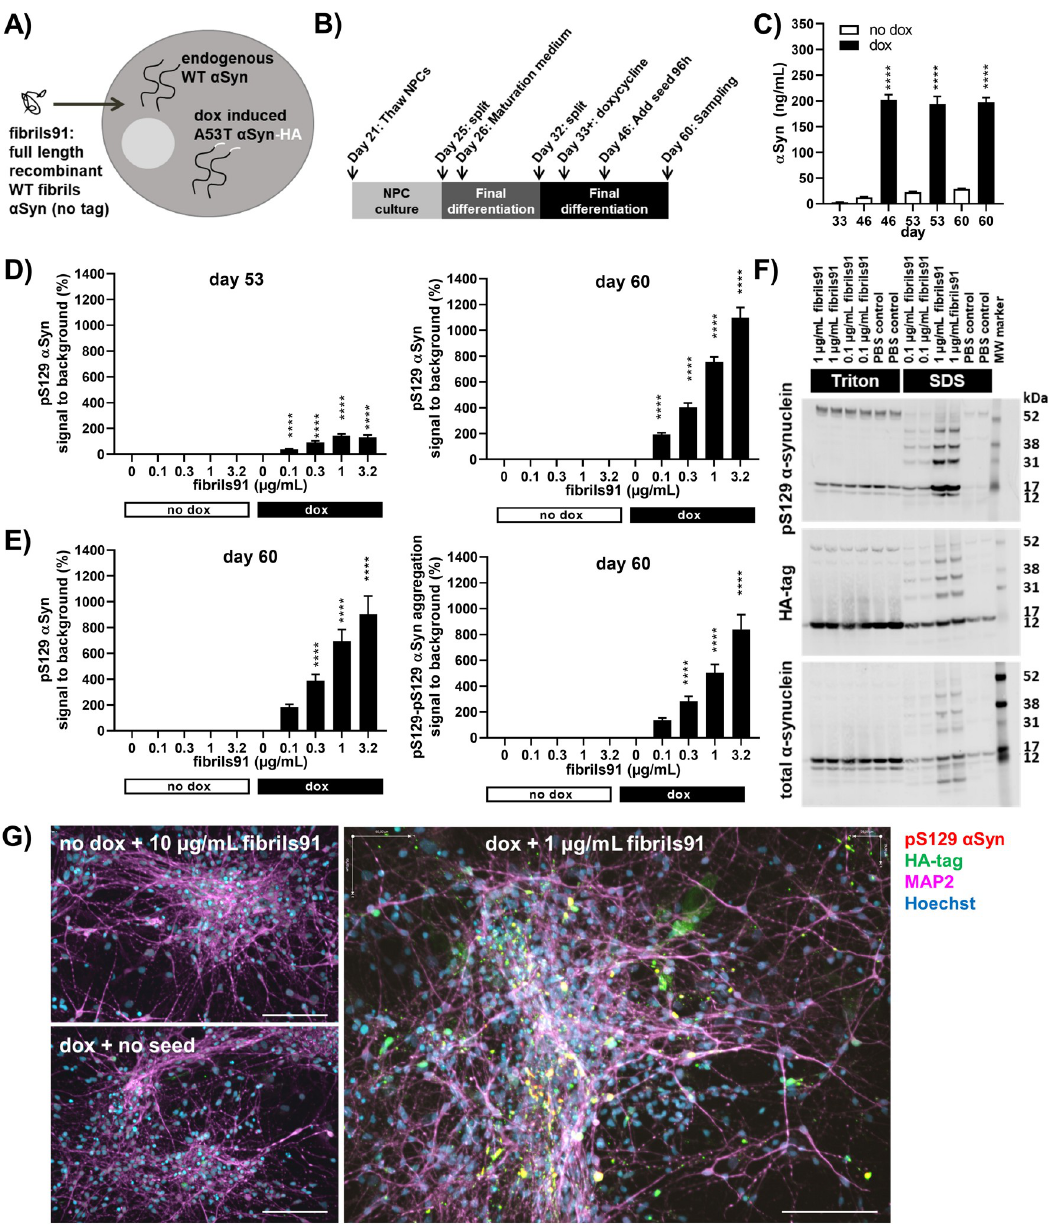
Fig 2. Exogenous fibrils91 seed α -synuclein aggregation in iPSC neurons expressing A53T α -synuclein. All graphs are shown as mean ± SEM and ���� p < 0.0001. (A) Overview of the in vitro seeding model. (B) Outline of seeding experiments. Day 21 neuronal progenitors were thawed, expanded and split before changing from neuronal expansion medium to neuronal maturation medium day 26. A final split was performed day 32 followed by addition of doxycycline (dox) day 33. Fibrils91 seeds were added day 46 and left on for 96h before the media was refreshed. Cells were harvested for analysis day 60 unless otherwise indicated. (C) Electrochemiluminescence immunoassays showed upregulation of endogenous α -synuclein ( α Syn) levels during neuronal differentiation. Doxycycline treatment resulted in stable A53T α -synuclein overexpression. Data were analyzed by one-way ANOVA followed by Sidaks’s multiple comparison test comparing doxycycline treated with non-treated for each timepoint (n = 3, m = 4). (D) FRET assays for pS129 α -synuclein showed a fibrils91-concentration and time dependent increase in the signal in doxycycline treated cells. Data were analyzed by one-way ANOVA followed by Dunnett’s multiple comparison test comparing to fibrils91 untreated samples for doxycycline treated and non-treated, respectively (n = 4, m = 6). (E) FRET assays for pS129 α -synuclein and aggregated pS129-pS129 α -synuclein on identical sample sets showed strong correlation. Data were analyzed by one-way ANOVA followed by Dunnett’s multiple comparison test comparing to fibrils91 untreated samples for doxycycline treated and non-treated, respectively (n = 4, m = 6). (F) Western blotting for pS129 α -synuclein, HA-tag and total α -synuclein in the Triton-soluble (Triton bar) and Triton-insoluble SDS-soluble (SDS bar) fractions from doxycycline treated neurons exposed to PBS, 0.1 μ g/mL or 1 μ g/mL